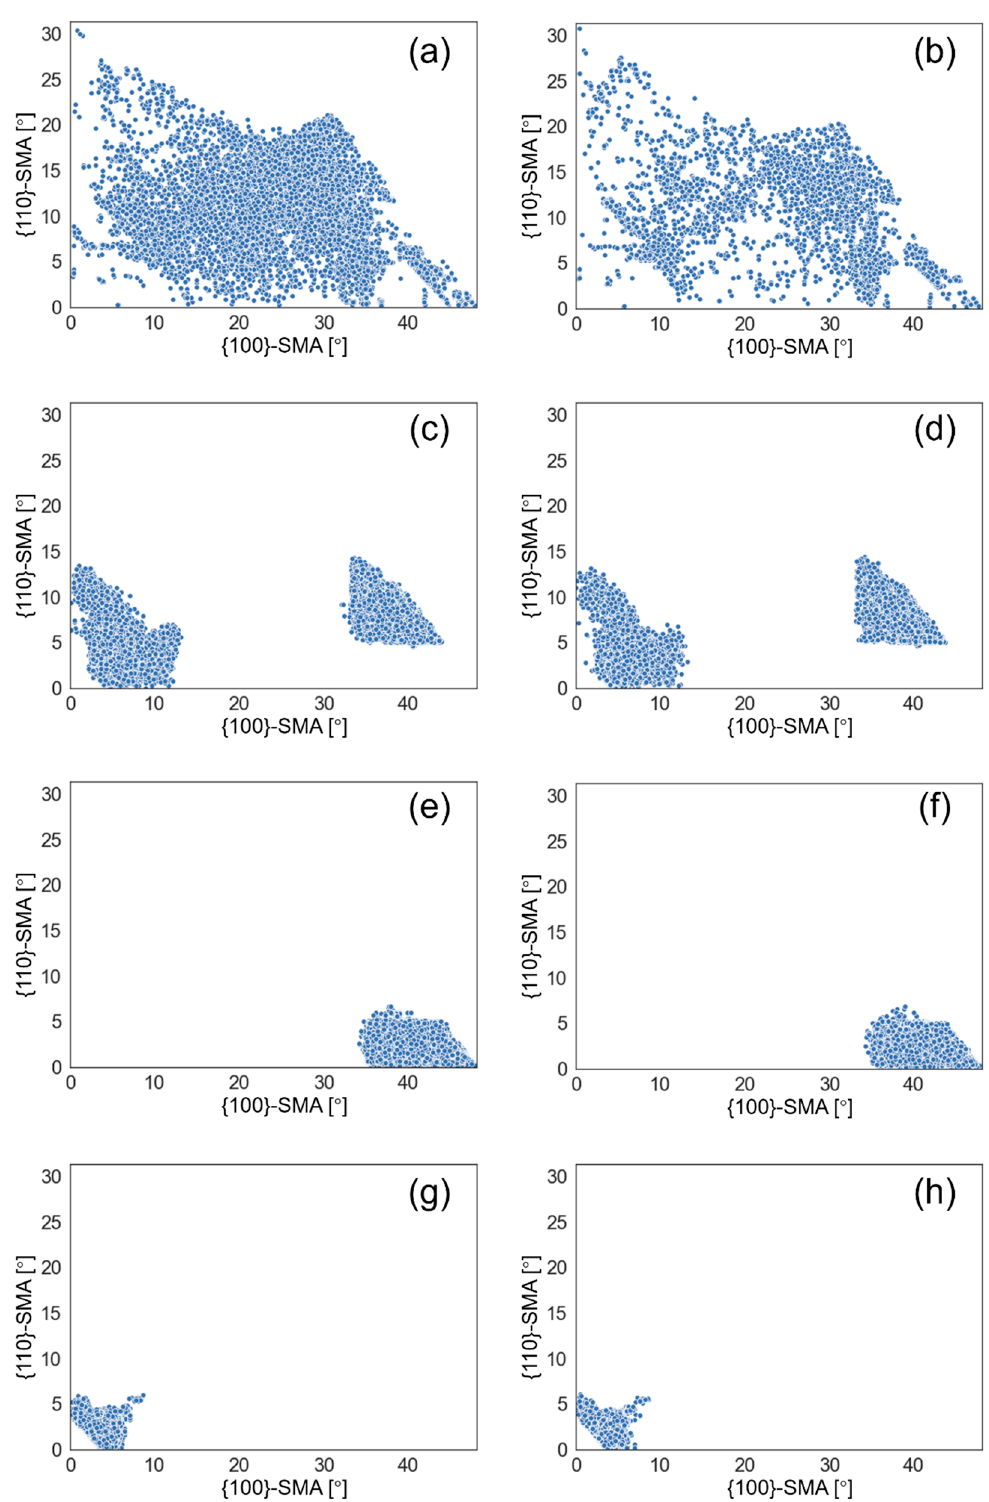
Figure 10. The relationship between {100}-SMA and {110}-SMA of different types of boundaries (( a , b ) PAGBs; ( c , d ) packet boundaries; ( e , f ) block boundaries; and ( g , h ) sub-block boundaries) in: A930 ( a , c , e , g ); and A1050 ( b , d , f , h ).